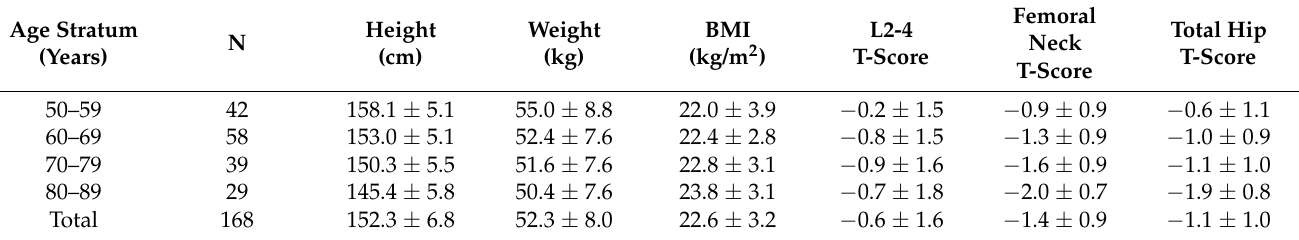
Table 1. Baseline characteristics of study subjects.